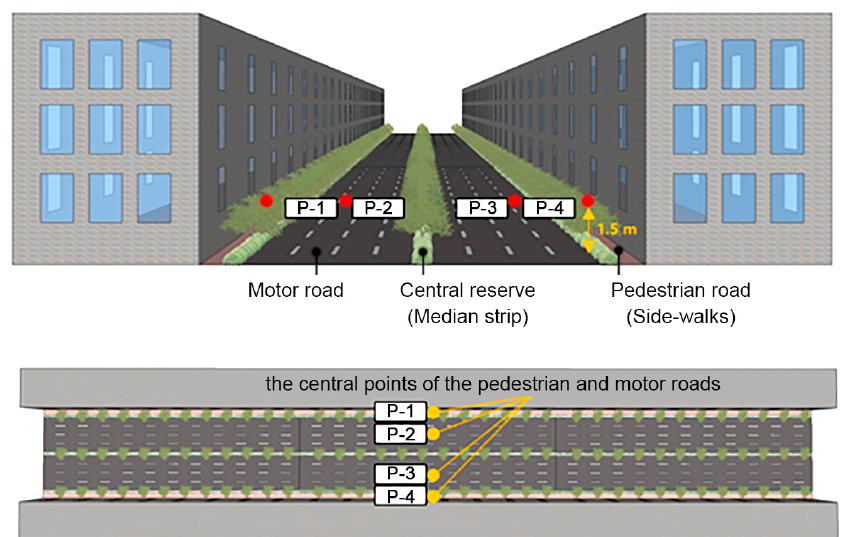
Figure 8. Measurement sites of particulate matter (PM 2.5 ) concentration for the quantitative analysis conducted in this study; pedestrian road (P-1), leeward motor road (P-2), windward motor road (P-3), and windward pedestrian road (P-4).